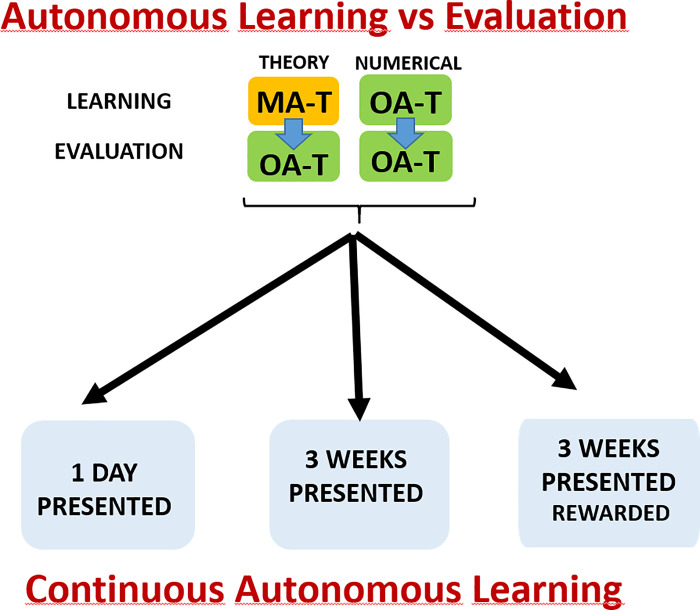
Scheme of the strategy followed to accurately measure the autonomous work of students and the influence of rewards.